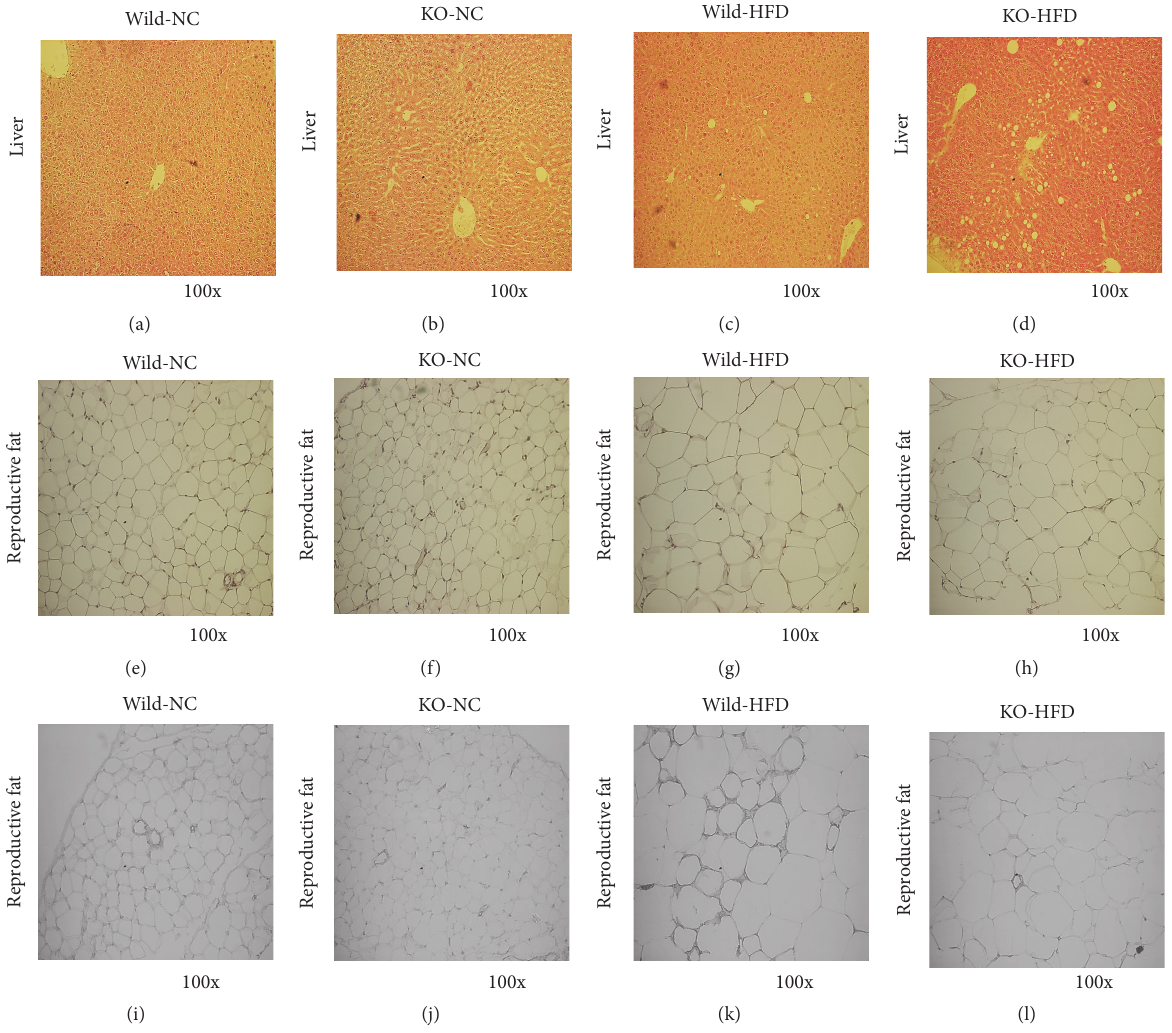
Figure 4: Histological analysis of liver and fat tissues in Mig-6 f/f and Mig-6 d/d mice. Microscopic appearance of liver and reproductive fat with H&E staining ( × 200). (a–d) liver and (e–h) reproductive fat. (i–k) Macrophage-specific staining in the reproductive fat tissues. The IHC of paraffin sections of the reproductive fat tissues was performed using antibody against macrophages ( × 200).